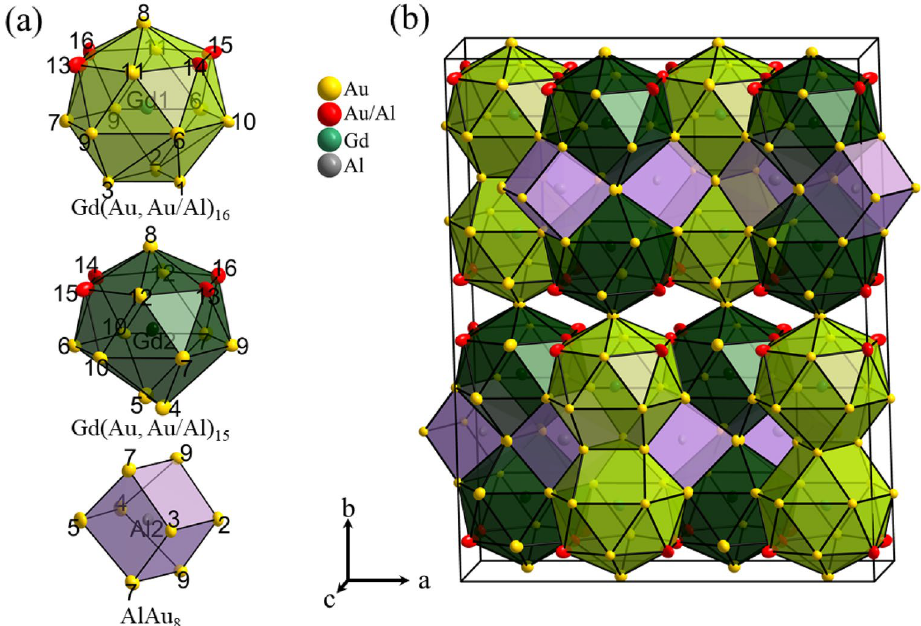
Figure 3. Crystal structure of GdAu 6.75−x Al 0.5+x . ( a ) Polyhedral units used to describe the structure. The polyhedra have been proportionally scaled with respect to each. ( b ) Arrangement of the polyhedra in the unit cell. All atomic positions are displayed by thermal ellipsoids at 90%